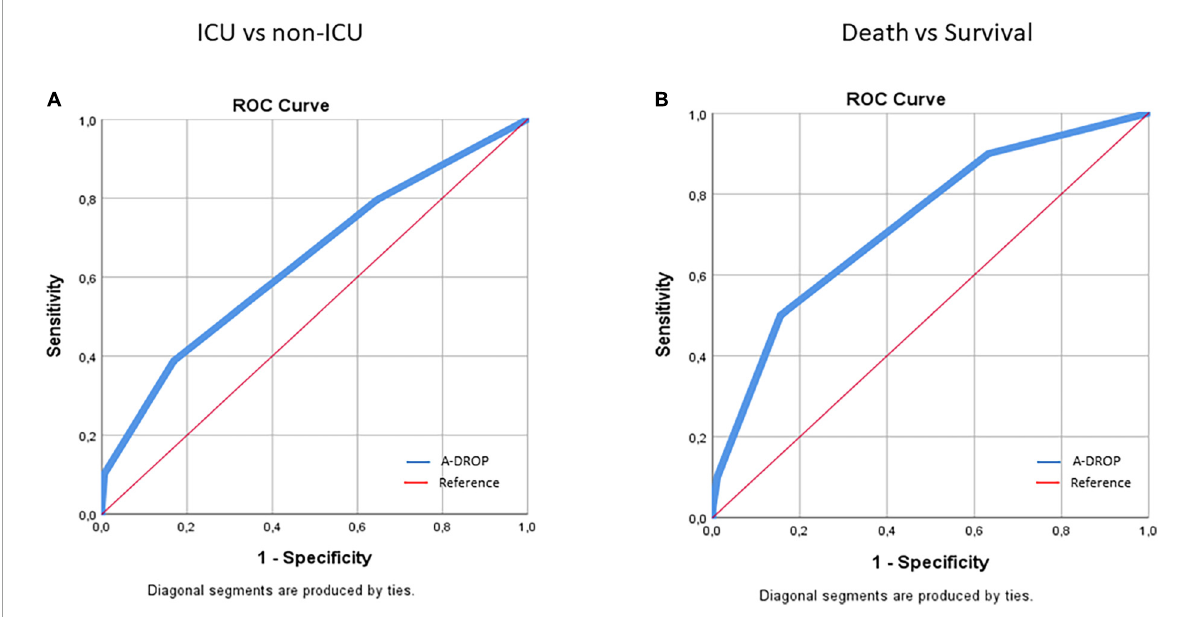
FIGURE1 ROC curve analysis of the association of A-DROP values with the need for ICU admission (A) and death (B) in COVID-19 patients.